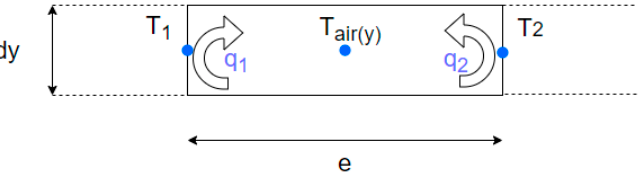
Figure 12. Schematic of convective heat transfer for a differential control volume of the air cavity.